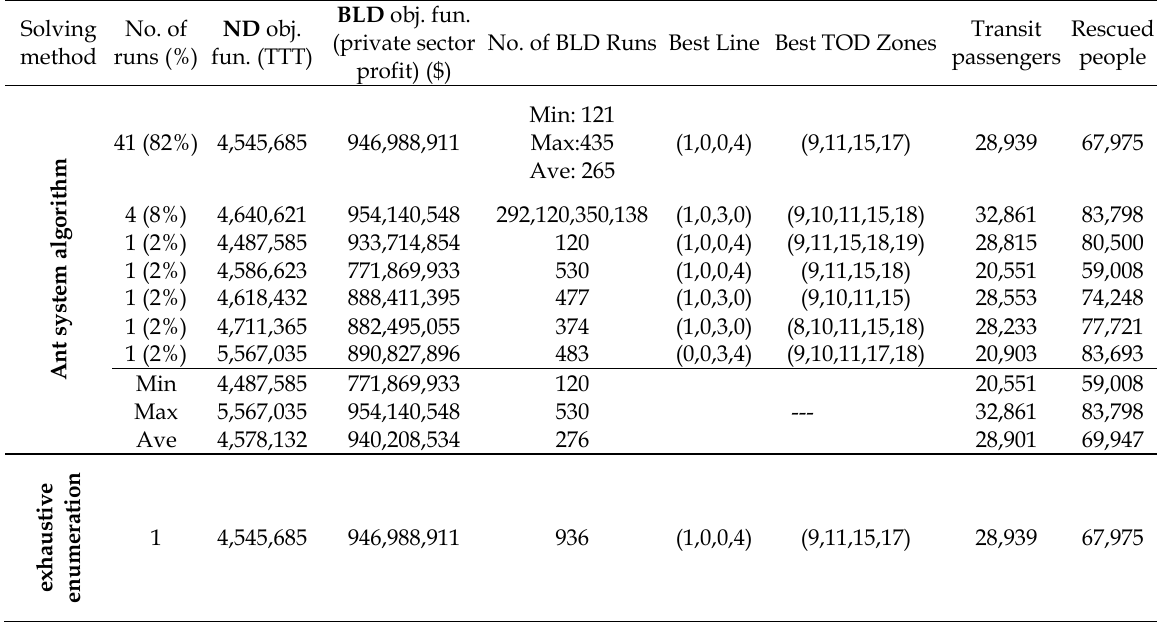
Comparison of the results of 50 runs of Ant System vs. exhaustive